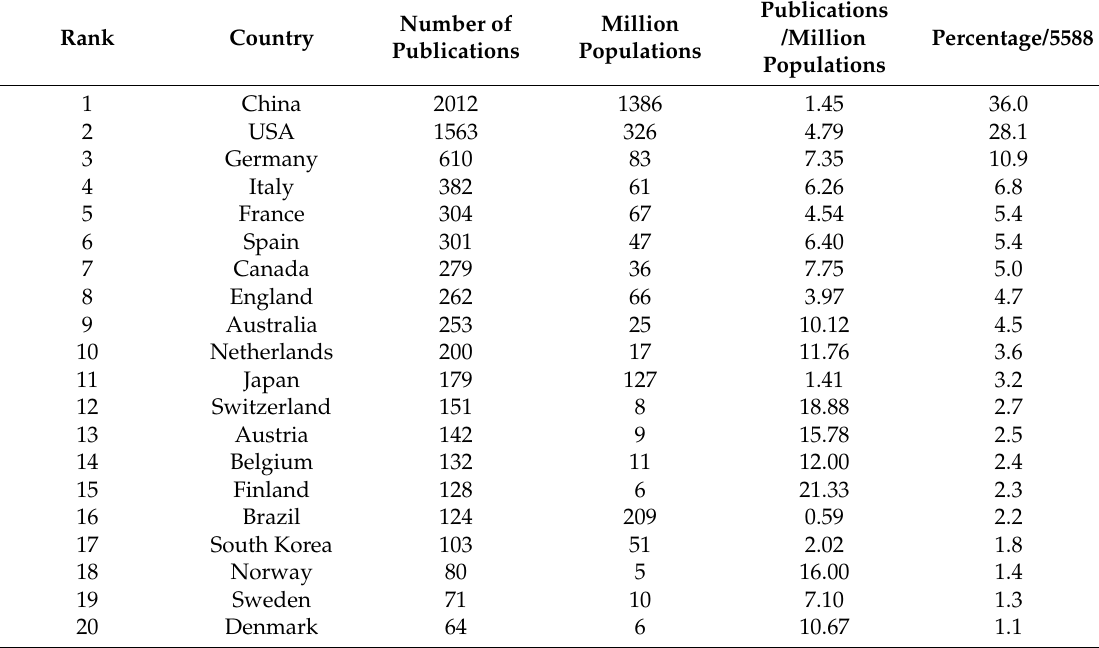
Table 7. Most productive countries (territories) of Remote Sensing Open Access Journal (RS OAJ) publications (Top 20).